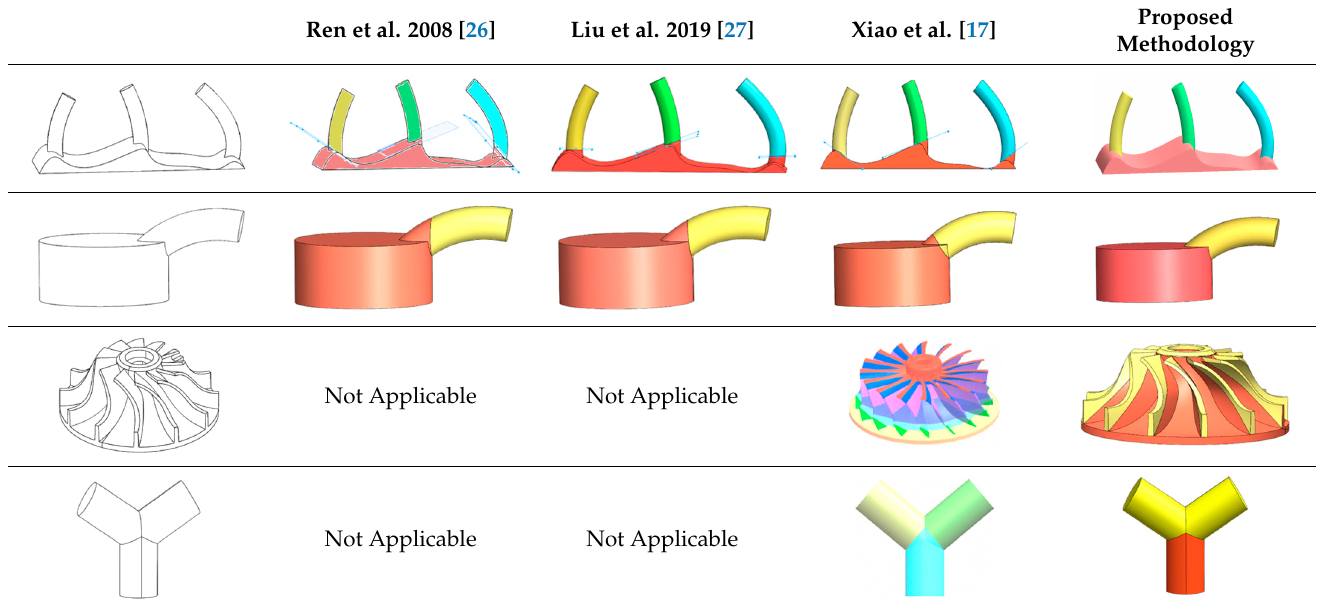
Table 2. Decomposition results from existing methods and proposed one.